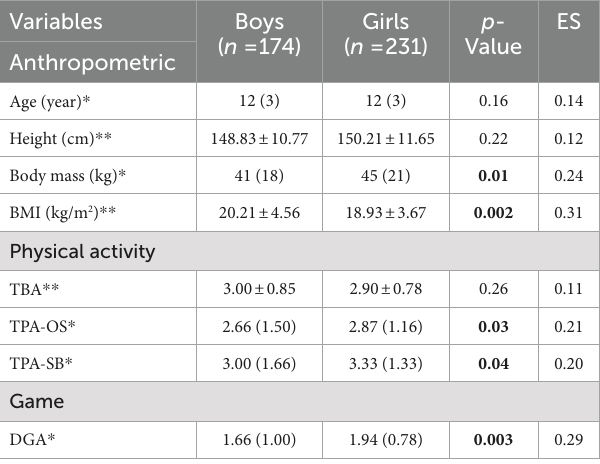
TABLE 2 The variation of anthropometric variables, physical activity, and digital game addiction scores by gender. Variables